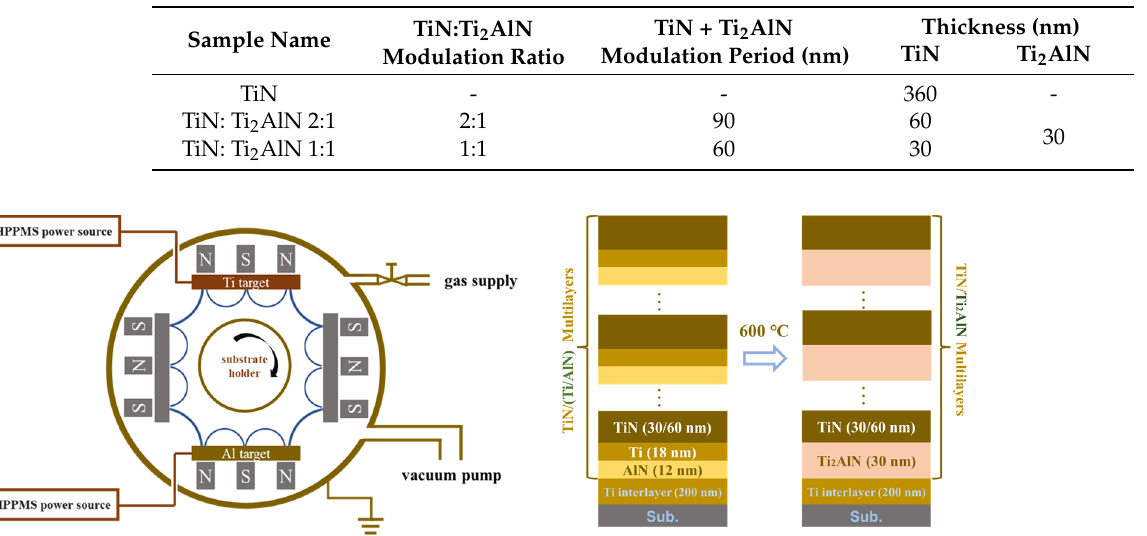
Table 1. Modulation period and ratio of TiN/(Ti/AlN) and TiN/Ti 2 AlN multilayers.